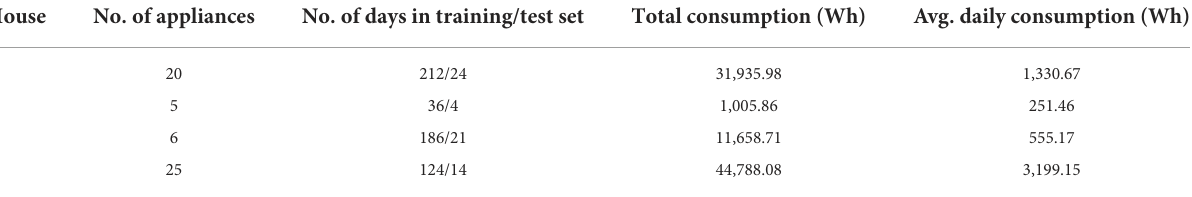
TABLE 6 UK-DALE dataset statistics.